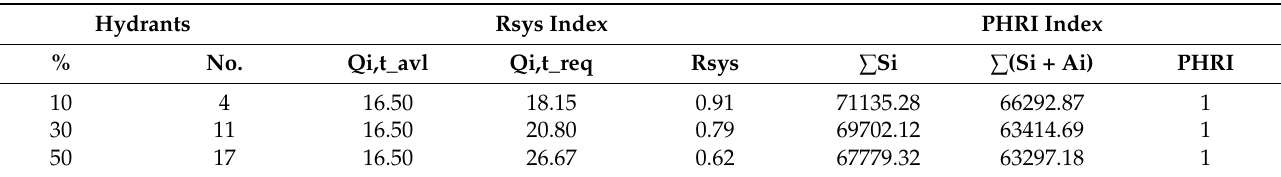
Table 6. “Rsys” and “PHRI” results, for scenario 1 in shifts.